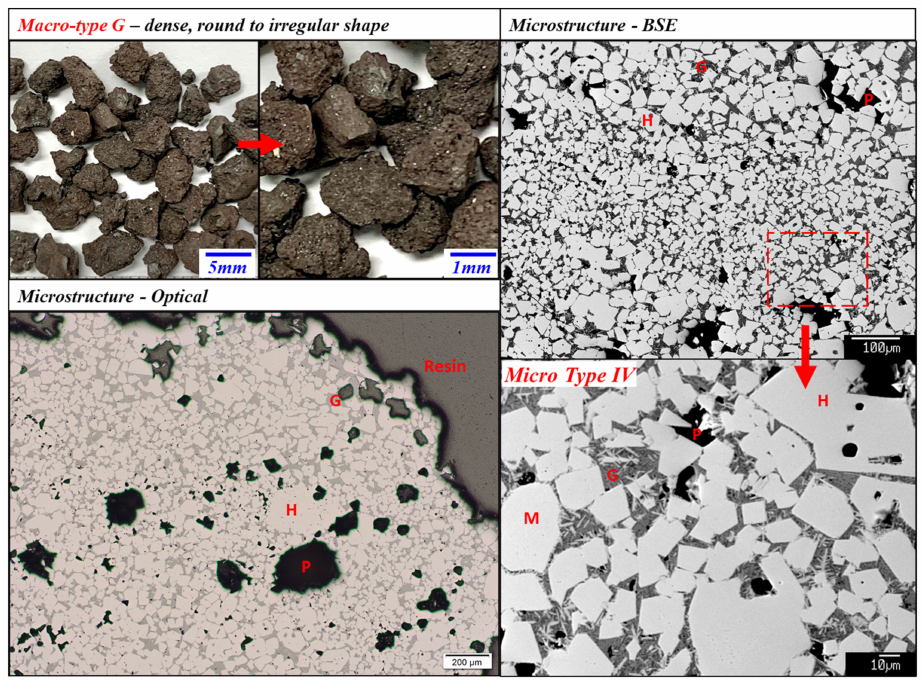
Figure 10. Typical microstructures of return samples Macro-Type G, dense, round to irregular shape, taken on optical microscope and back scattered electron microscope, G = Glass; H = Hematite; M = Magnetite; and P =